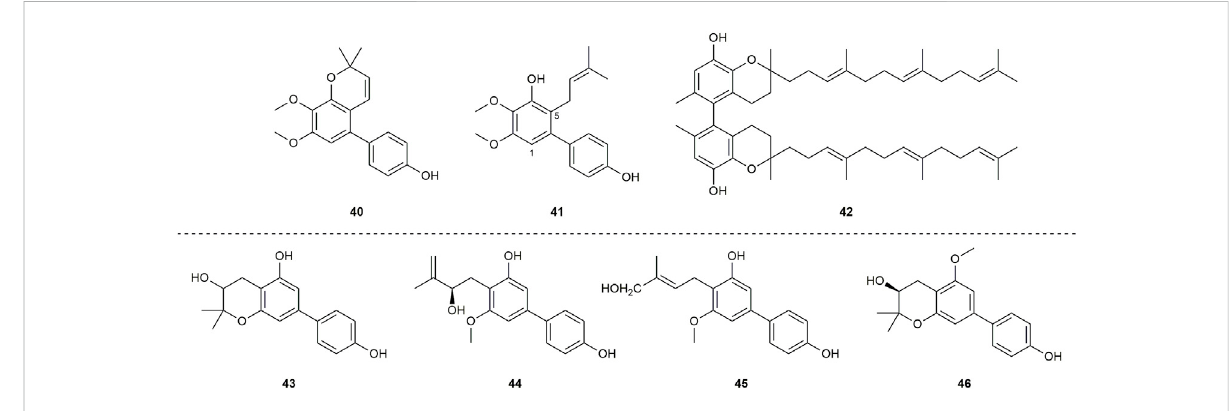
FIGURE 4 Structures of biphenyls 40 – 46